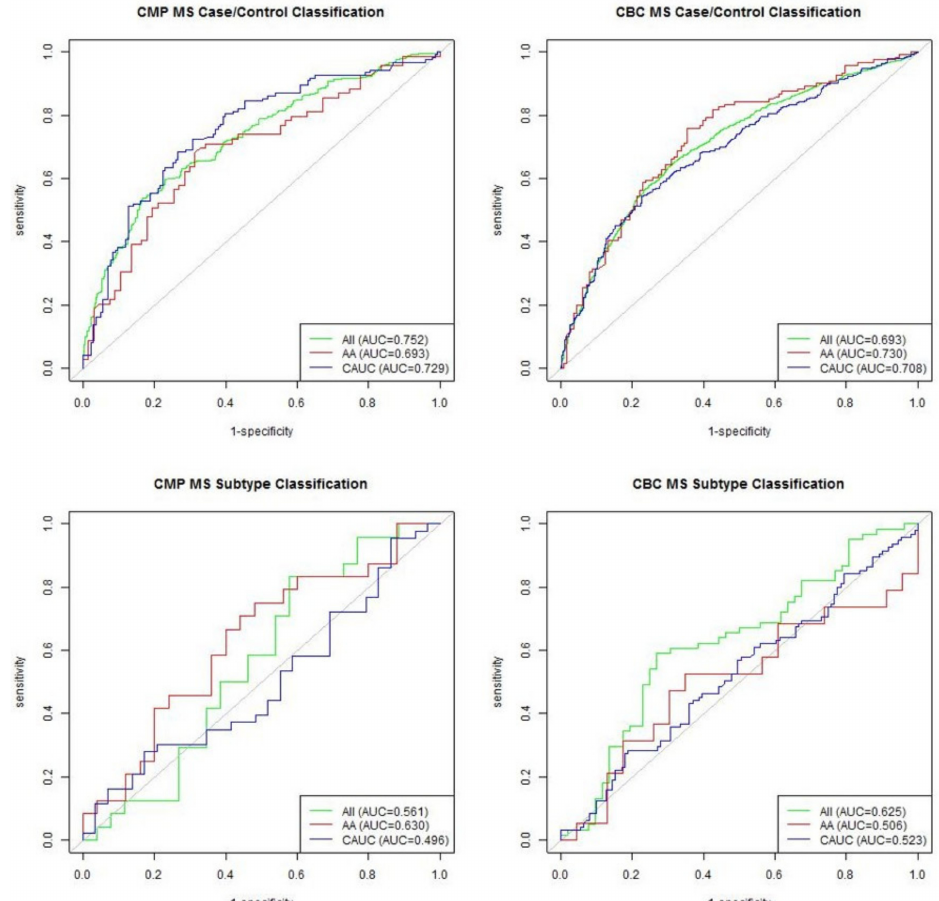
Figure 1. ROC curves showing performance of each random forest